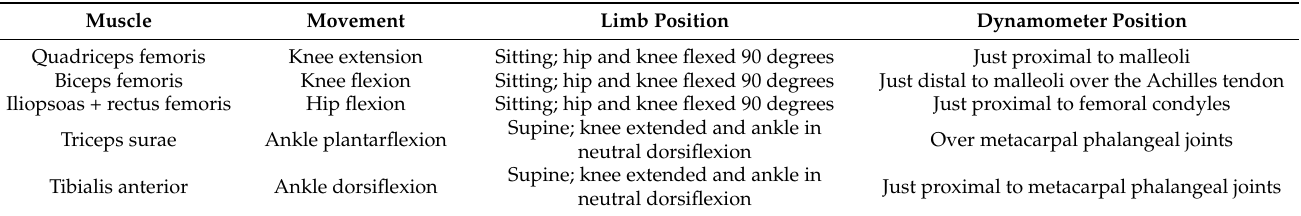
Table 1. Muscle testing positions with transducer